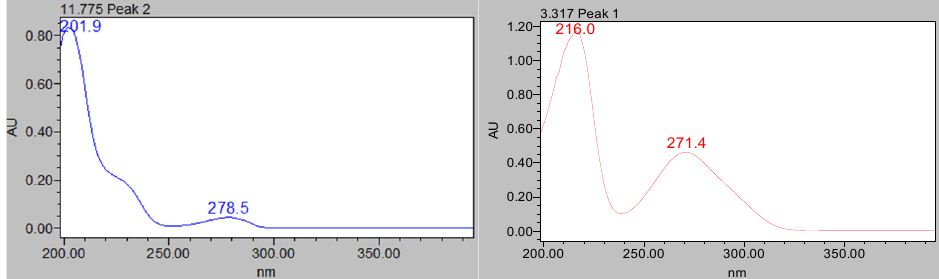
Figure 3. UV-Vis spectrum of catechin compounds ( left ) and gallotanines compounds ( right ).